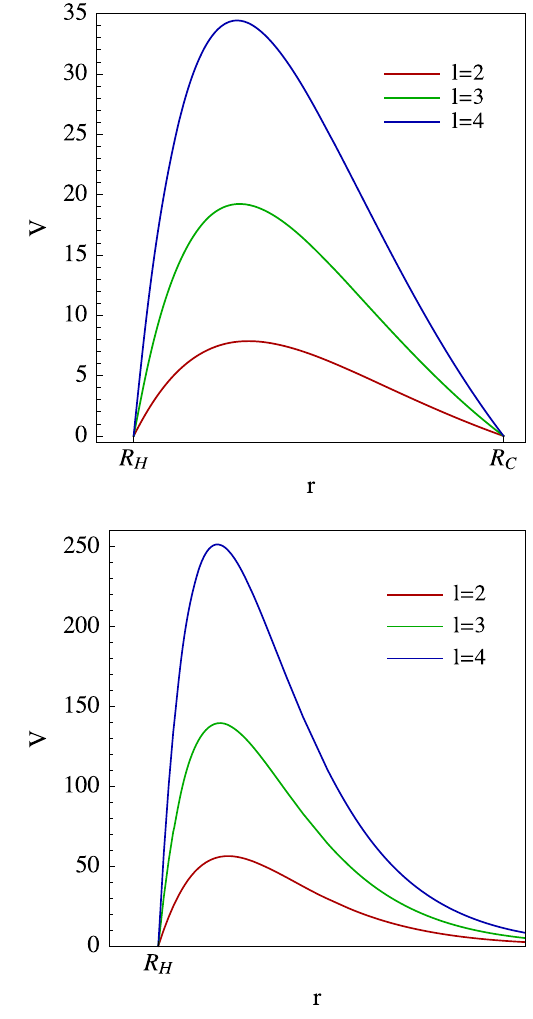
Fig. 2 Effective potential for odd perturbations in DGP branch (upper graph) and RS branch (lower graph). R H represents the position of the event horizon and R C the cosmological horizon. We see that both branches have always a positive effective